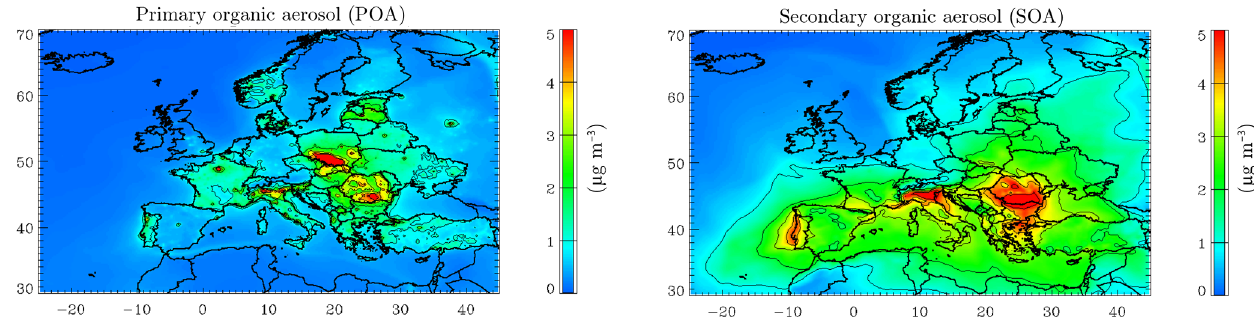
Figure 4. Modelled average POA (left) and SOA (right) concentrations for the period between 25 February and 26 March 2009.